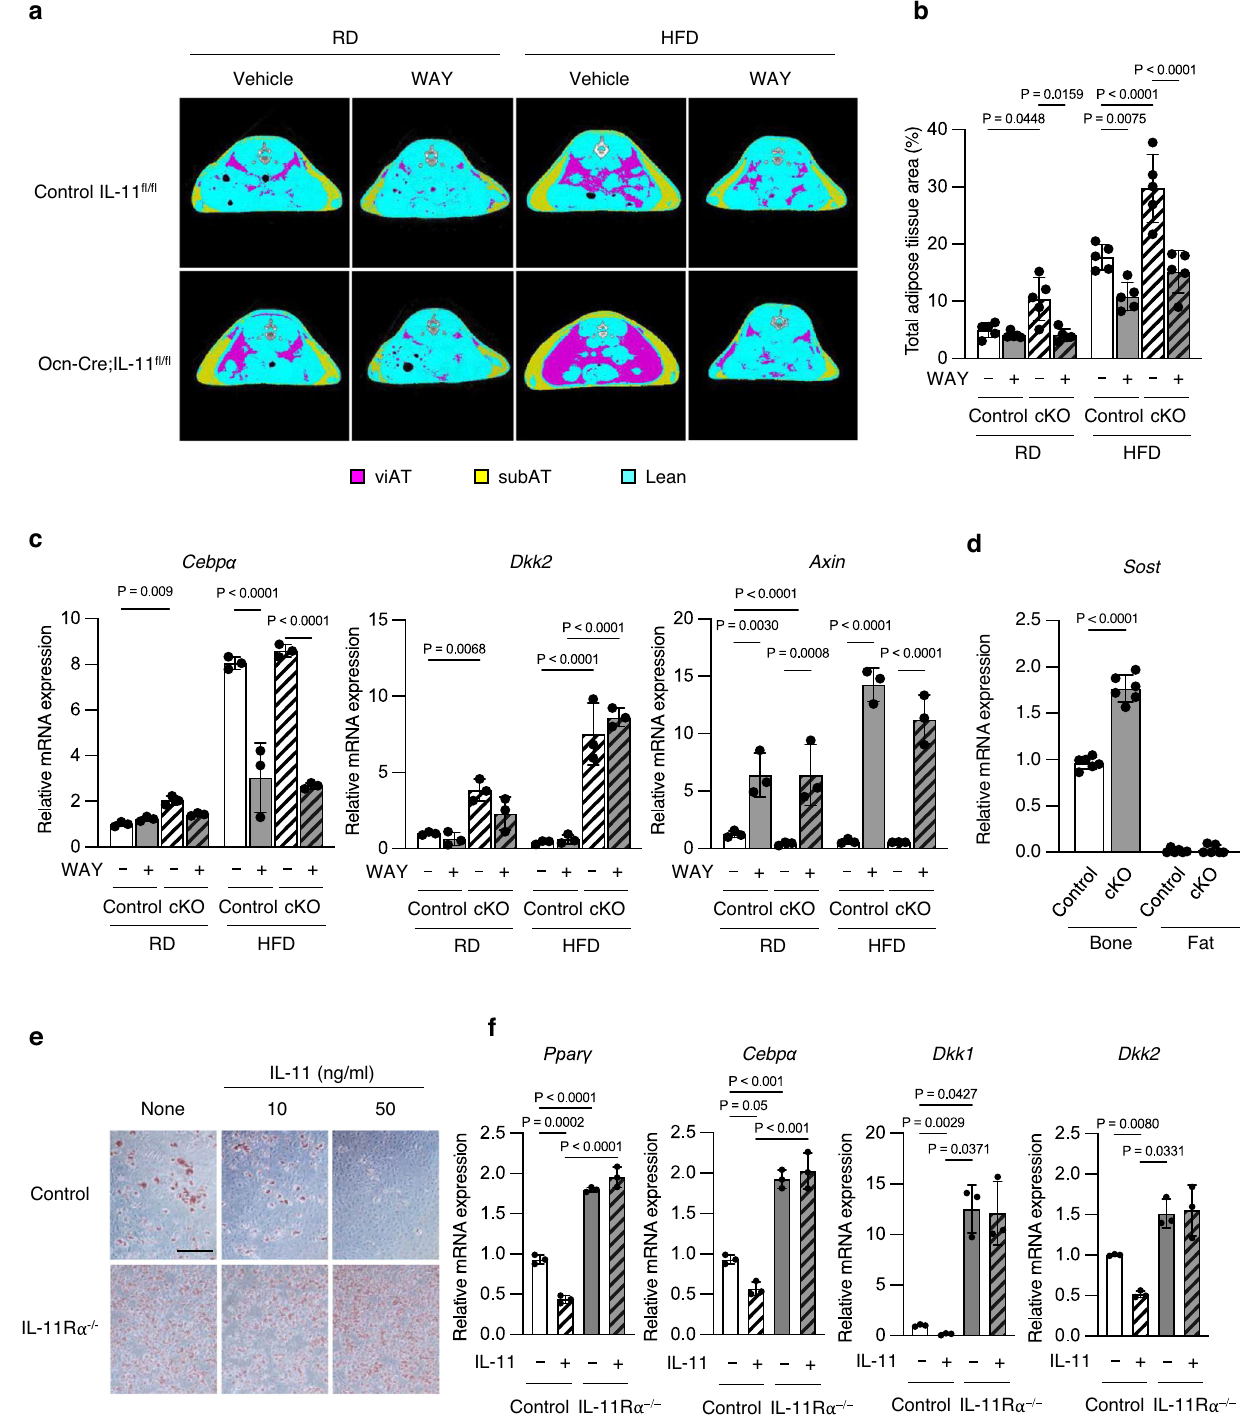
Fig.7|SignalingpathwayofIL-11intheadiposetissueinosteoblast/osteocyte- speci fi c IL-11 − / − mice. a Micro-CT scan at L5 level. Pink, viAT; yellow, subAT; blue, leanmass;white,vertebralbone,and b quantitativeanalysisofadiposetissueinIL- 11 fl / fl control and Ocn-Cre;IL-11 fl / fl mice on RD or HFD in the presence or absence of WAY-262611, a β -catenin agonist and a Dkk1 antagonist. WAY-262611 at a dose